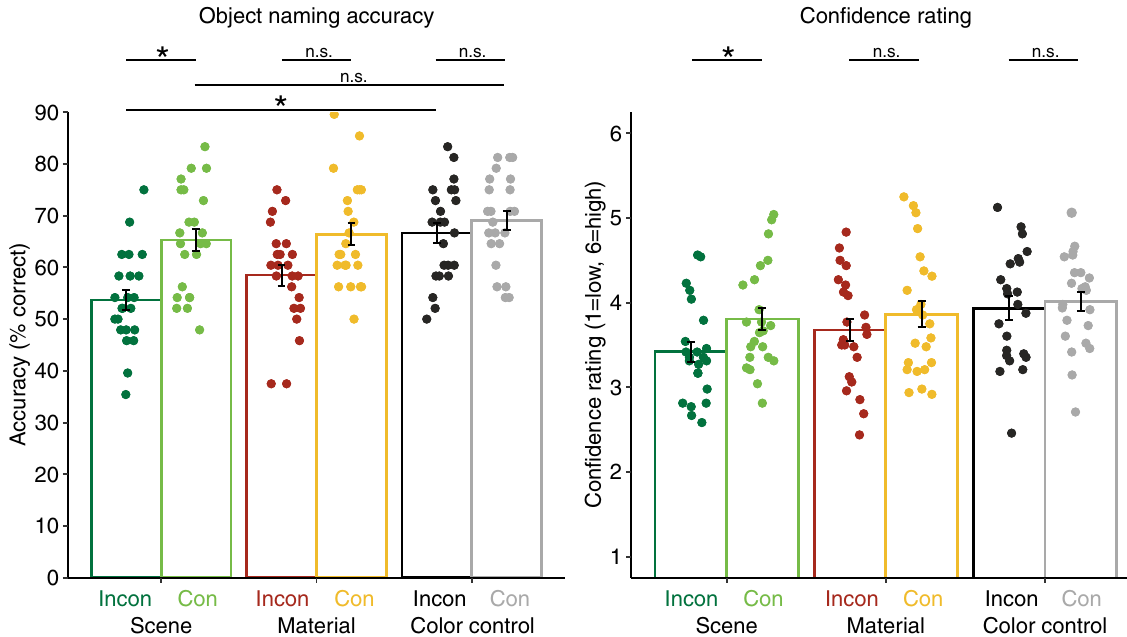
Figure 2. Object naming accuracy (left panel) and confidence rating (right panel) for inconsistent (Incon) and consistent (Con) objects superimposed on scenes, materials, and color controls (scrambled materials), respectively. Data points represent individual participants’ means; bars represent the means per condition. Error bars depict the standard error of the means. Asterisks indicate significant comparisons ( p < 0.05); non-significant comparisons are marked with